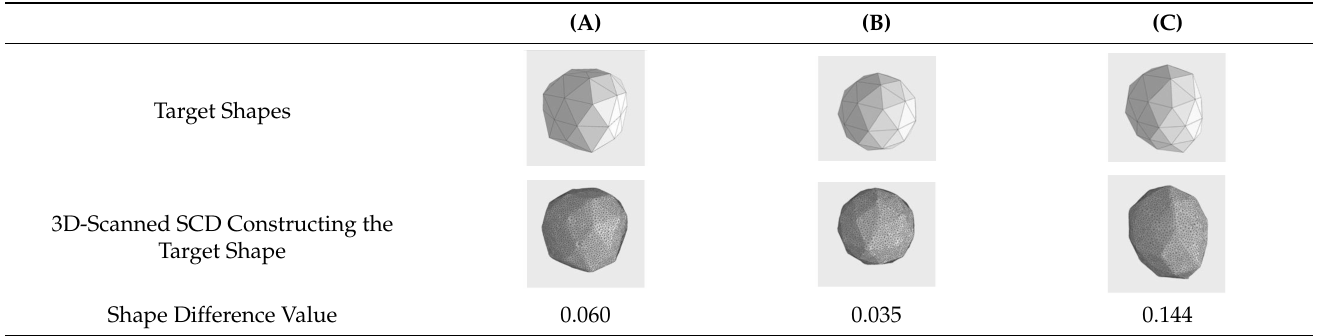
Table 1. Resolution of SCD depending on the nV Icosahedron.